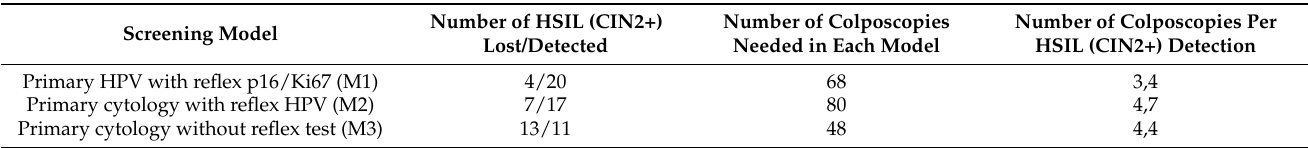
Table 12. Performance characteristics of analyzed screening models: loss/detection of HSIL (CIN2+) vs. number of colposcopies